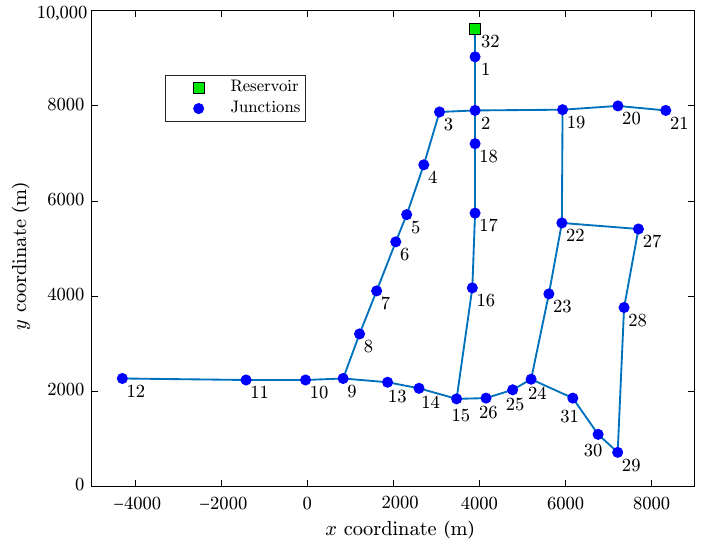
Figure 1. The Hanoi